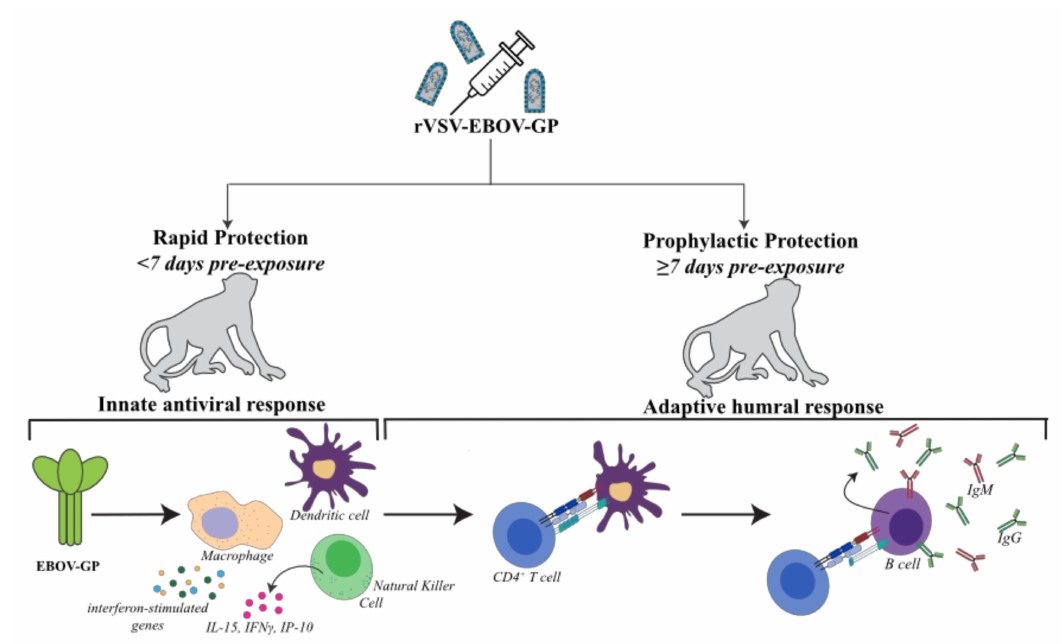
Figure2. rVSV-EBOV-GPmechanismsofprotectioninnonhumanprimates. rVSV-EBOV-GPvaccination < 7 days before EBOV challenge in nonhuman primates induces a protective immune response predominantly driven by innate immune and characterized by activated antigen presenting cells (e.g., macrophages, dendritic cells), NK cells secreting cytokines like IL-15 and the upregulation of antiviral interferon-stimulated genes in response to EBOV-GP recognition. In contrast, protection in macaques vaccinated > 7 before EBOV challenge is mediated by humoral adaptive immunity, in which APC-stimulated CD4 + T cells promote B cell maturation and the production of IgG and IgM antibodies targeting